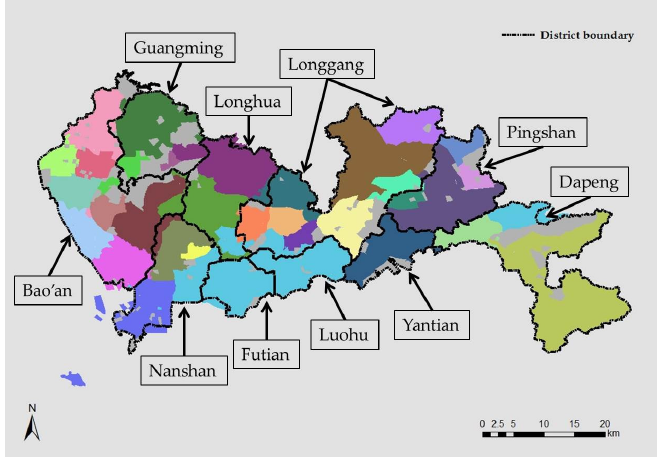
Figure 4. Overall interaction-based urban structure, colors indicate the component affiliations of the spatial units (same for the following maps).